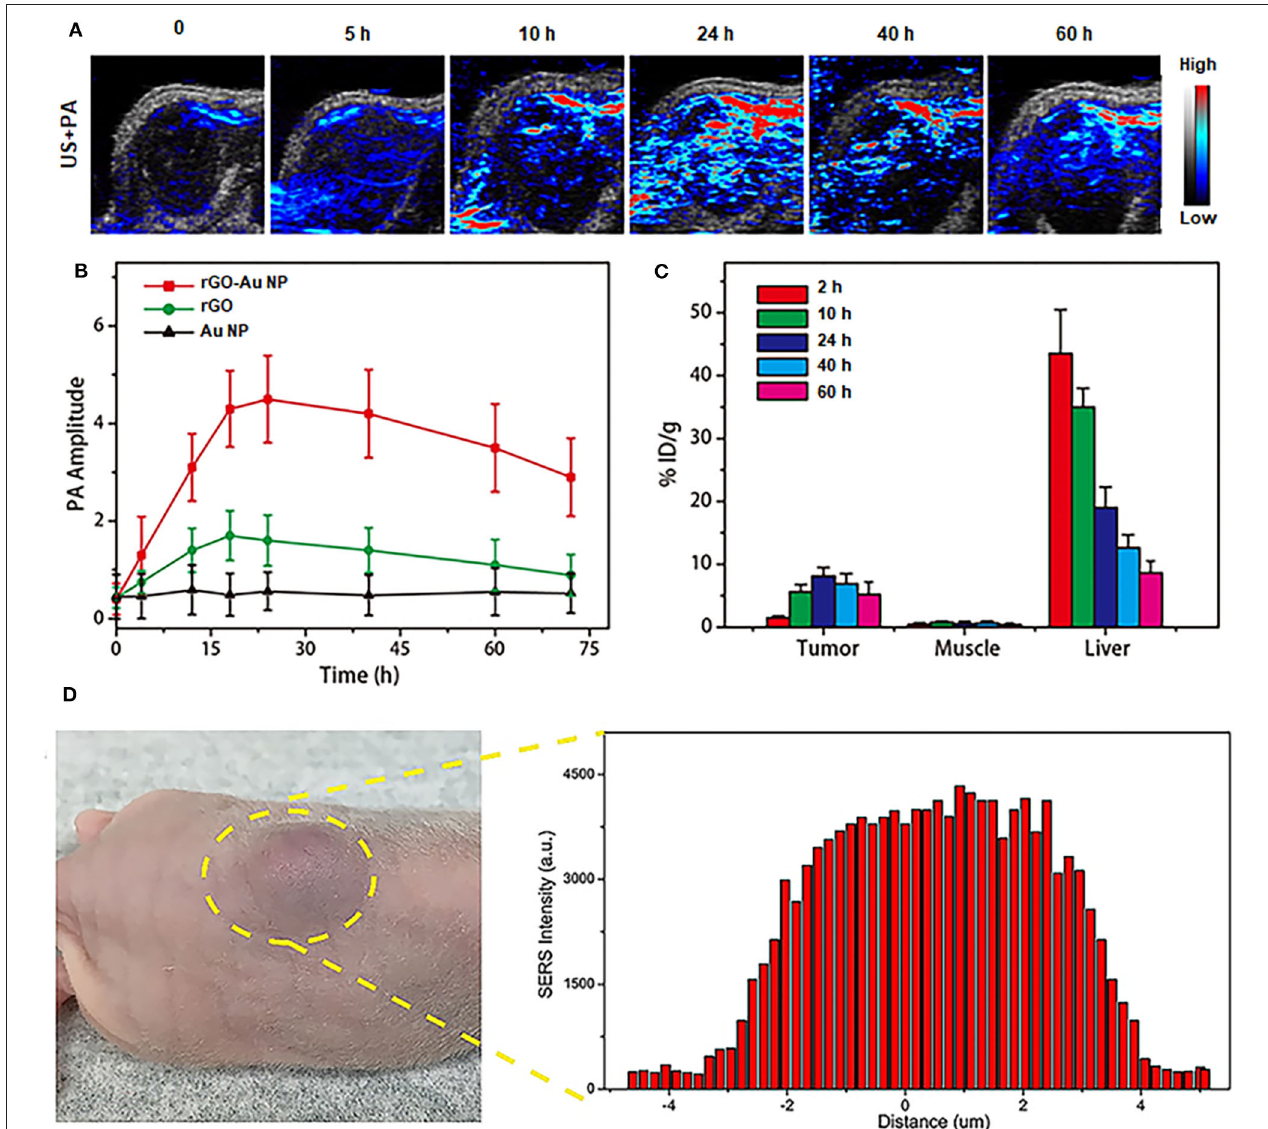
FIGURE 4 | In vivo NIR-II PA imaging. (A) 2D ultrasonic (US) and PA images of tumor tissues in SKOV-3 tumor-bearing mice treated with rGO-AuNP at different time points post-injection. (B) Variations of the PA signal amplitude in the tumor region treated with PBS, rGO, and rGO-AuNP at different time points post-injection. (C) Biodistribution of the rGO-AuNP in tumor, muscle and liver at different time points post-injection. (D) In vivo SERS signal of the tumor and its surrounding tissue to determine the boundary between tumor and normal